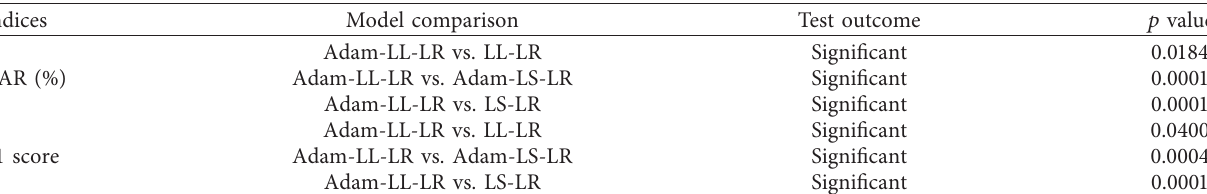
Figure 10: Model performances obtained from the repetitive data subsampling process: (a) CAR (%) and (b) F 1 score. Table 3: Wilcoxon signed-rank test